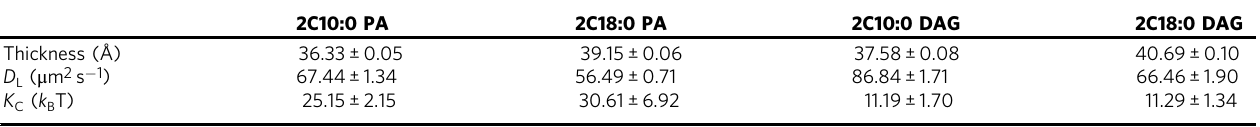
Table 1 Effect of shorter acyl chains on membrane